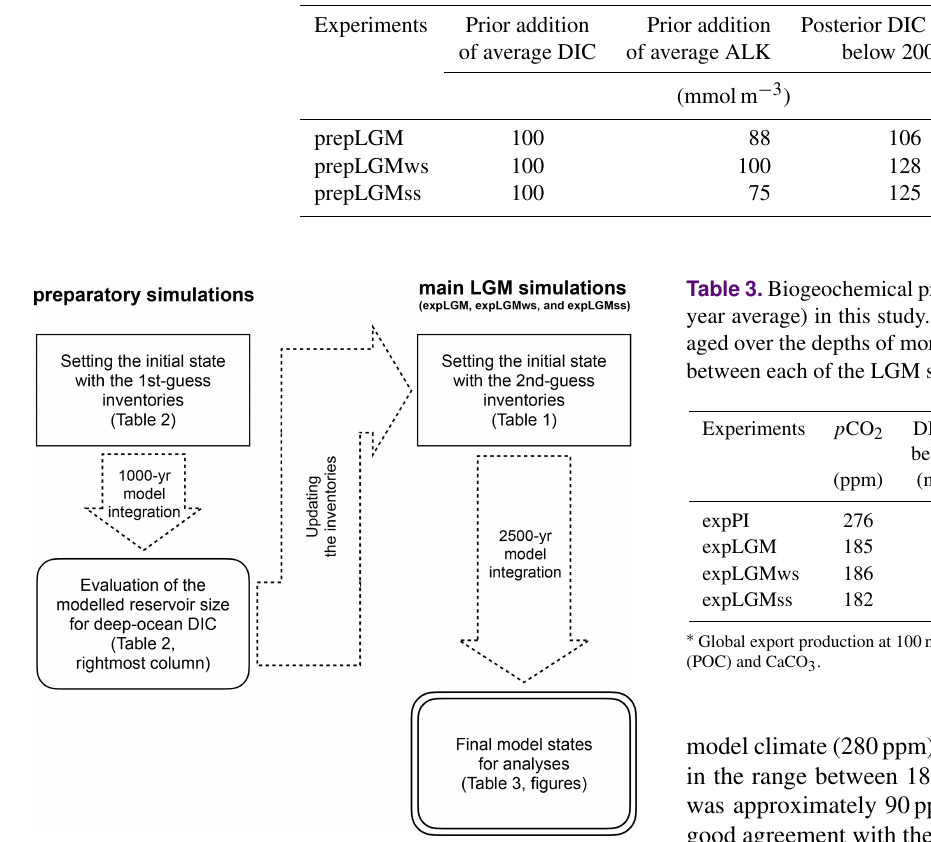
Figure 2. Workflow for the LGM carbon cycle simulations in this study.